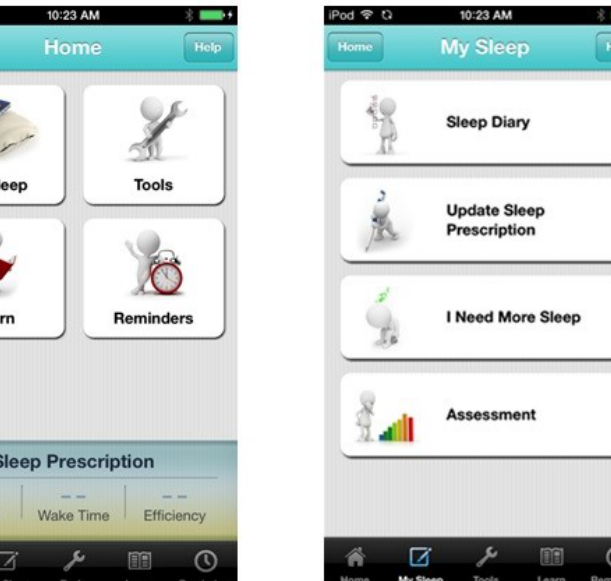
Figure 1. Example screenshots from CBT-i